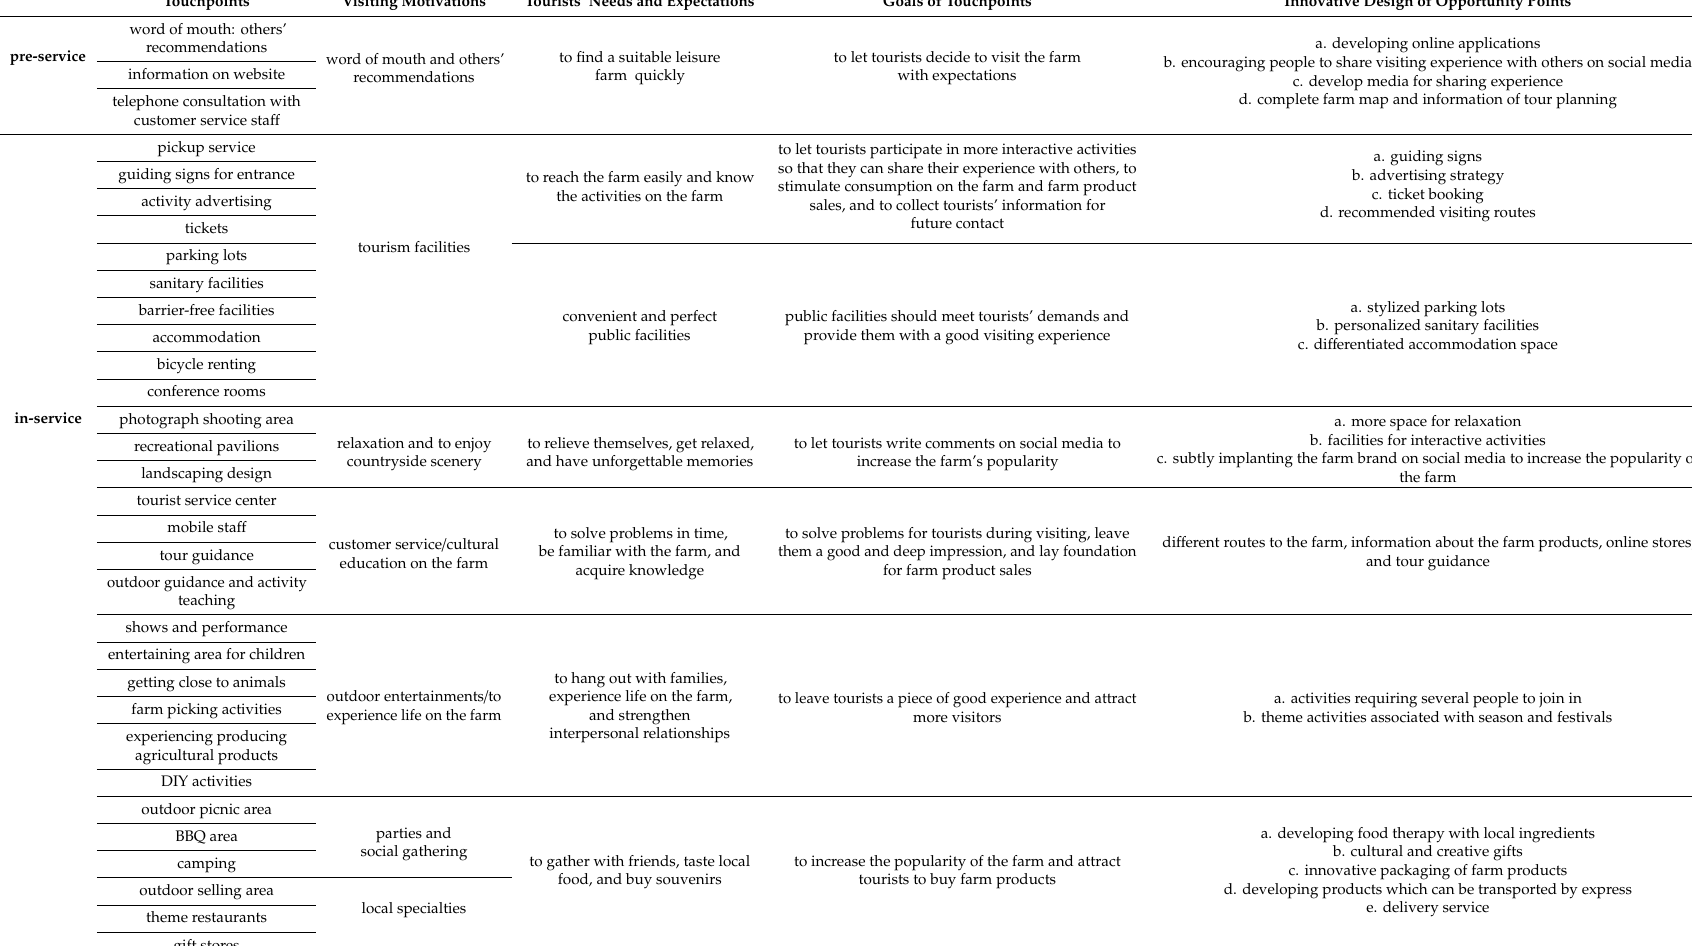
Table 2. Service design framework for leisure